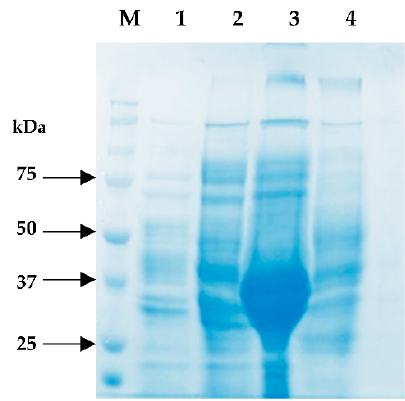
Figure 2. SDS-PAGE analysis showing the expression level and the solubility of Pk -LDH cultured in different broths. Overexpressed protein can be seen when using TB broth with added MgSO4 (lane A3). M: stained molecular weight markers in kDa (Protein ladder). Lane 1: LB Broth, Lane 2: M9 broth, Lane 3: Terrific broth, Lane 4: ZYP broth.